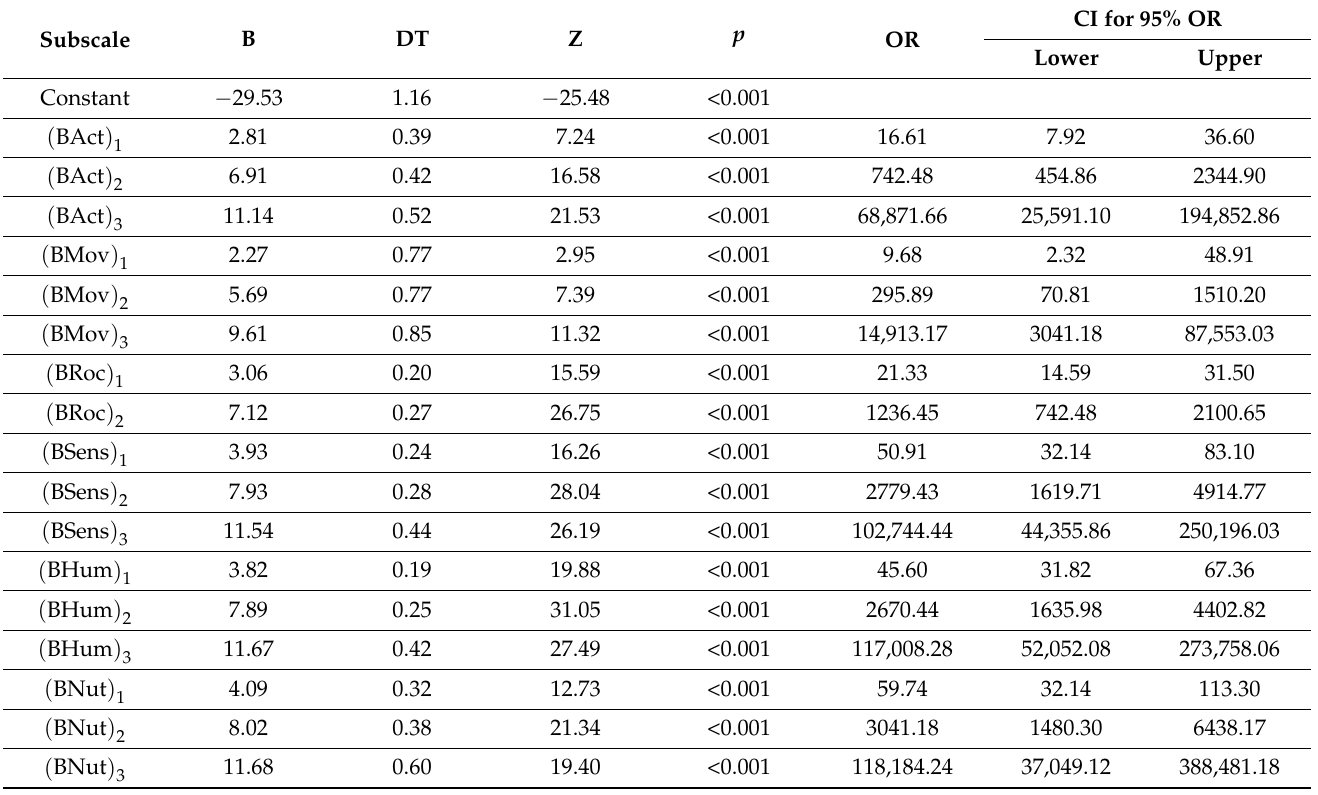
Table 2. Prognosis model for pressure ulcer